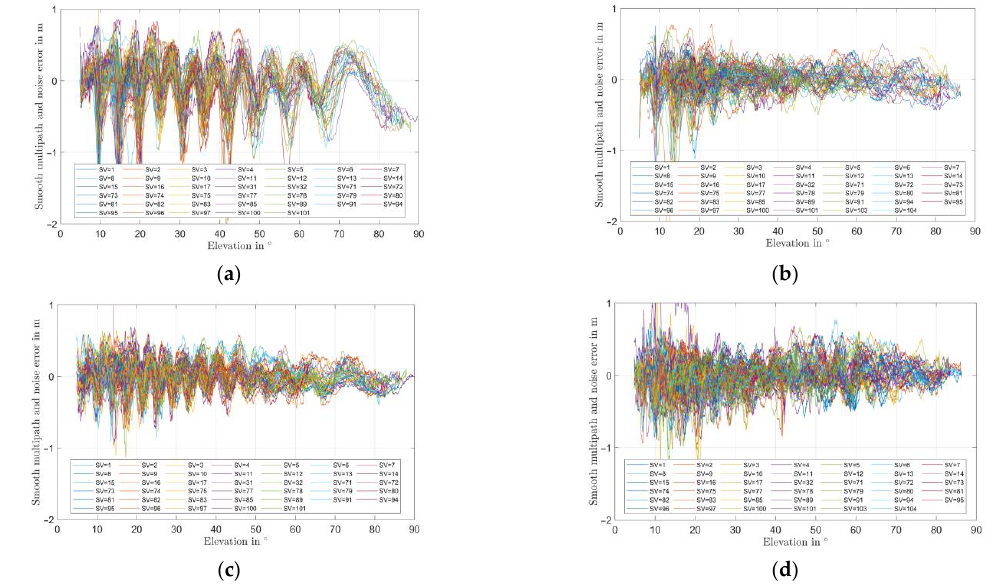
Figure 17. Estimated pseudorange multipath from GNSS measurements of the miniaturized GNSS array without vertical choke rings standalone or installed on a hex-rotor UAV with installation height of 110 mm. ( a ) L5/E5a, standalone; ( b ) L5/E5a, on UAV h = 110 mm; ( c ) L1/E1 standalone; ( d ) L1/E1, on UAV h = 110 mm.